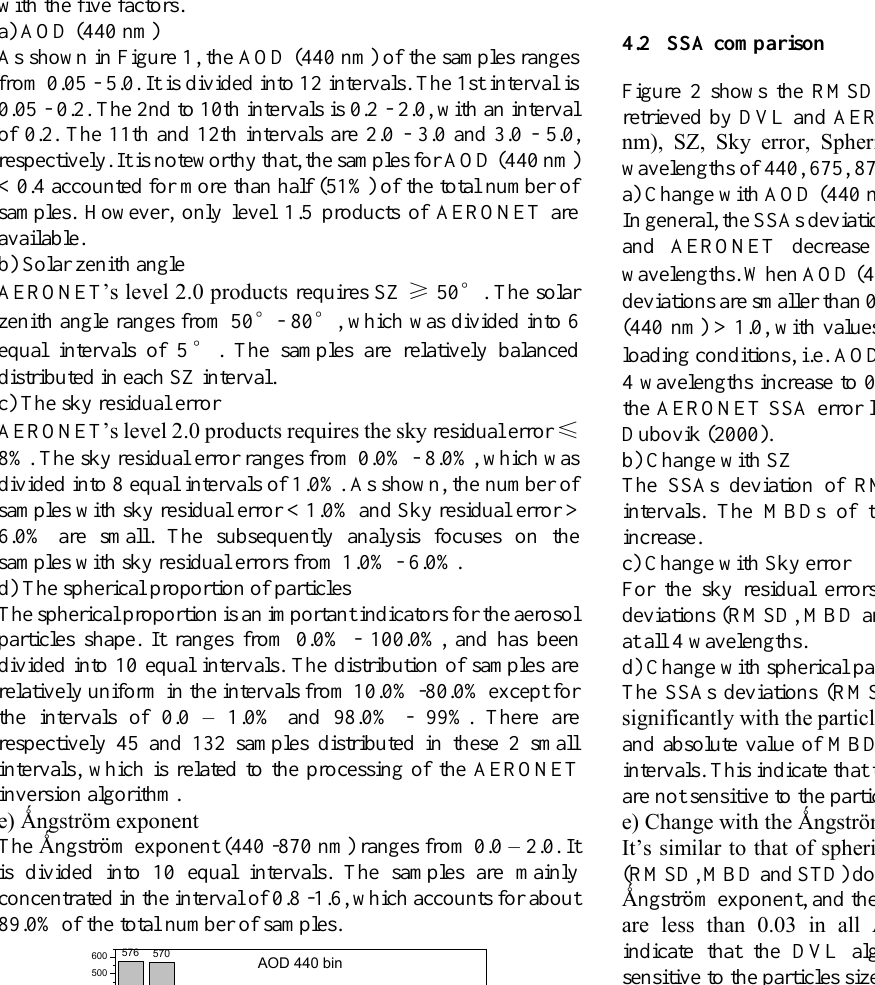
Figure 1 The frequency distribution of data